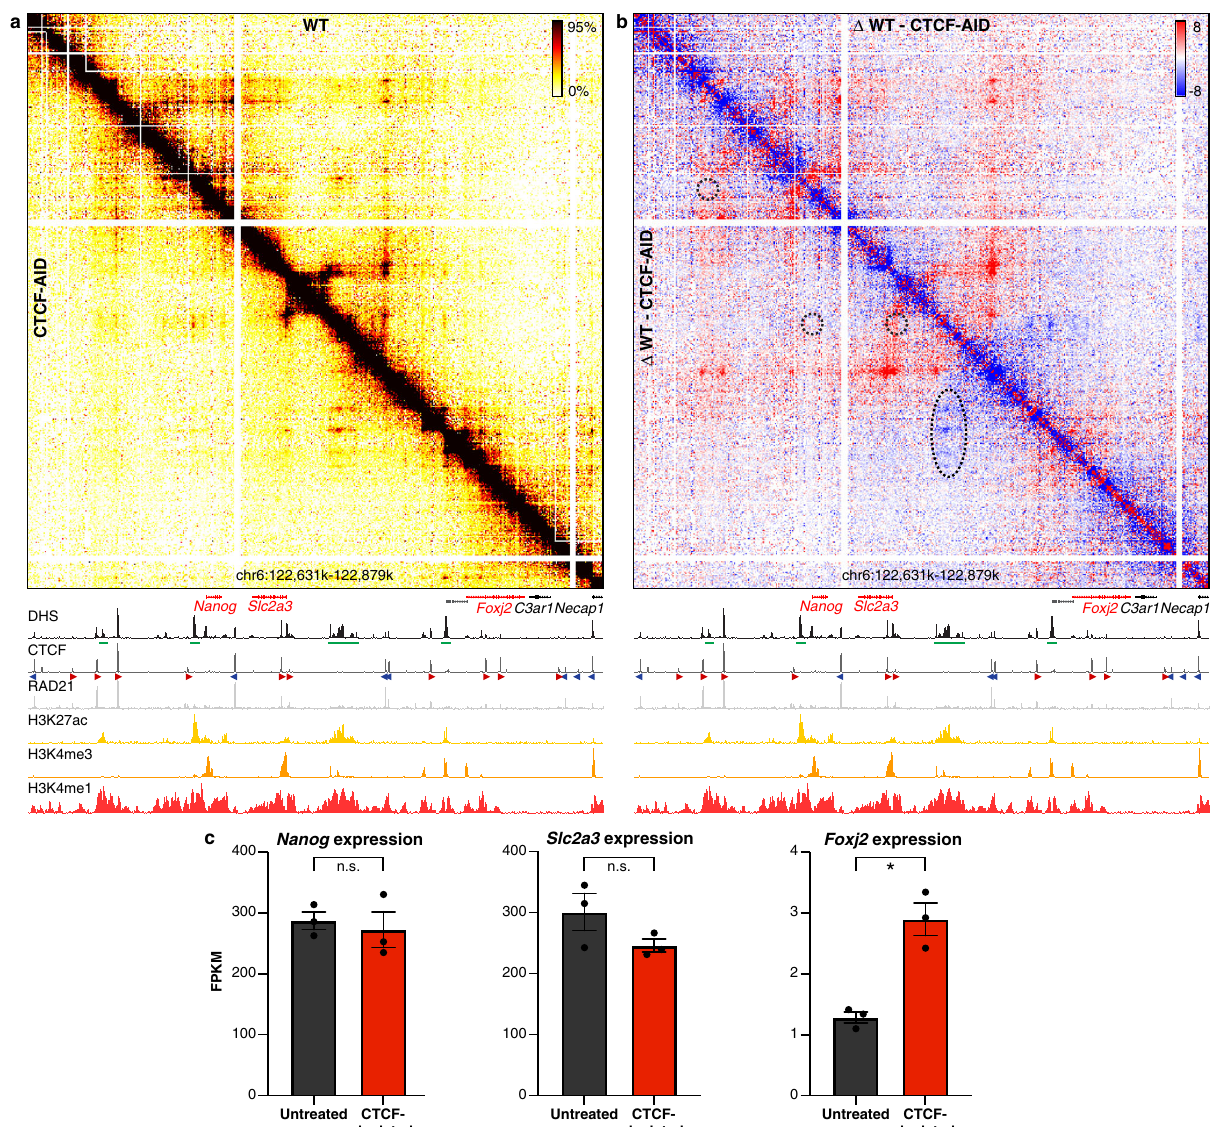
Fig. 4 CTCF depletion results in ectopic enhancer – promoter interactions in the Nanog locus. a Tiled-MCC contact matrices of the Nanog locus in wild- type mES cells (top-right) and auxin-treated CTCF-AID mES cells (bottom-left) at 500 bp resolution. b Differential contact matrix of the Nanog locus in which interactions enriched in WT mES cells are indicated in red and interactions enriched in auxin-treated CTCF-AID mES cells are indicated in blue. a – b Gene annotation (genes of interest in red, coding genes in black, non-coding genes in gray), DNase hypersensitive sites (DHS), and ChIP-seq data for CTCF, Cohesin (RAD21), H3K27ac, H3K4me3, and H3K4me1 are shown below the matrices. The axes of the DHS and ChIP-seq pro fi les are scaled to signal and have the following ranges: DHS = 0 – 10.25; CTCF = 0 – 3092; RAD21 = 0 – 3414; H3K27ac = 0 – 58; H3K4me3 = 0 – 90; H3K4me1 = 0 – 2064. Enhancers of interest are indicated in green below the DHS pro fi les. The orientations of CTCF motifs at prominent CTCF-binding sites are indicated by arrowheads (forward orientation in red; reverse orientation in blue). The dashed circles and oval in b highlight the following interactions of interest (from left to right): Nanog promoter and far upstream enhancer; Nanog promoter and downstream super-enhancer; Slc2a3 promoter and downstream super-enhancer; Foxj2 proximal cis -regulatory elements and upstream super-enhancer. The interactions between the Nanog and Slc2a3 promoters with the enhancers in the region appear unchanged upon CTCF depletion (despite the loss of CTCF-mediated interactions directly upstream of the Slc2a3 promoter), whereas the interactions between the proximal cis- regulatory elements of Foxj2 and the super-enhancer are increased. c Expression of Nanog , Slc2a3 , and Foxj2 in untreated (left) and auxin-treated (right) CTCF-AID mES cells, derived from RNA-seq data, normalized for fragments per kilobase of the transcript, per million mapped reads (FPKM). The bars represent the average of n = 3 replicates and the error bars indicate the standard error of the mean. Signi fi cant (*) and non-signi fi cant (n.s.) changes in expression are indicated. Nanog : P = 0.7030; Slc2a3 : P = 0.1774; Foxj2 : P = 0.0001 (calculated using Cuffdiff analysis and adjusted for multiple comparisons, as previously decribed 27 ). Source data are provided as a Source Data fi the localized insulating properties are not altered by depletion of cohesin depletion, but insulation mediated by CTCF-binding sites cohesin, despite the complete loss of long-range contacts between within the super-enhancers or promoter regions is reduced upon CTCF-binding sites upon cohesin depletion (Fig. 5, Supplemen- CTCF depletion (Fig. 5, Supplementary Fig. 17). This suggests tary Figs. 17, 18). The nano-scale structures of the investigated that CTCF mediates local insulation independent of cohesin- promoters and super-enhancers are also not grossly affected by mediated loop extrusion.